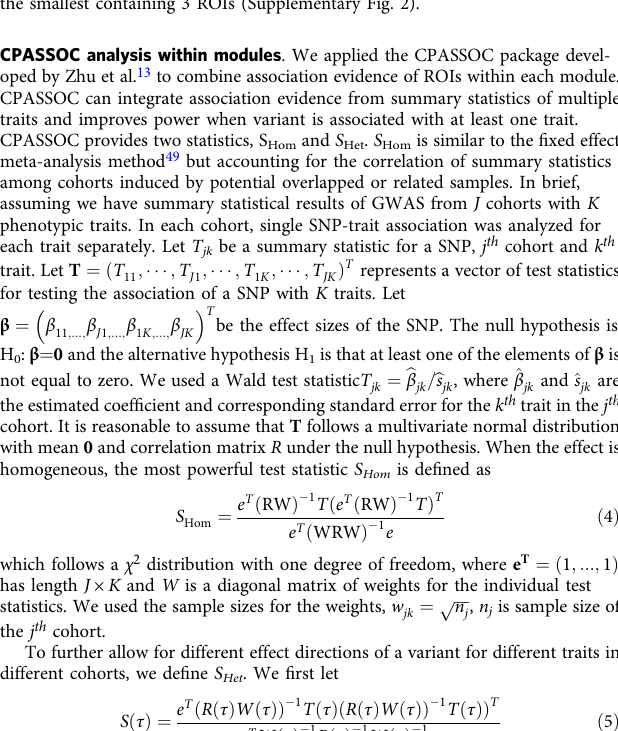
Supplementary Table 1. The Manhattan plots and Q-Q plots of CPASSOC analysis and single ROI GWAS for this module were showed in Fig. 1 and Supplementary Fig. 2. Genetic analysis of AV-45 PET imaging . 18 F-Florbetapir (AV-45) PET imaging was performed at baseline and 2-year follow-up for participants enrolled in the ADNI GO and two phases 22 . UC Berkeley extracted weighted AV-45 standardized uptake value ratio (SUVR) means for four main cortical regions: frontal, anterior, and posterior cingulate, lateral parietal and lateral temporal regions (version 2019.4.12) for ADNI-GO2 participants. They also calculated composite SUVR for cortical which is weighted SUVR mean in frontal, cingulate, parietal and temporal regions. These data can be downloaded from the ADNI database. We used the SUVR mean of composite region including whole cerebellum, pons/brainstem and eroded white matter as reference. Mean AV-45 SUVR of frontal, cingulate, lateral parietal, lateral temporal and composite cortical relative to the reference were calculated. The annual percent change in SUVR means at 2-year follow-up com- pared to baseline was used as the main quantitative phenotype for genetic analysis. The annual percent changes in AV-45 SUVR for all fi ve brain regions were approximately normally distributed (Supplementary Fig. 20). We collected 369 individuals with both SUVR measures for baseline and 2-year follow-up and whole-genome sequencing data. The samples included 120 healthy people, 26 people with AD, 64 people with late mild cognitive impairment (LMCI) and 159 people with early mild cognitive impairment (EMCI) diagnosed at baseline. The samples characteristics and demographics for samples are shown in Supplementary Table 11. WGS data from 817 ADNI participants were downloaded from the ADNI dataset. WGS was performed using blood-derived genomic DNA samples and sequenced on the Illumina HiSeq2000 using paired-end read chemistry and read lengths of 100bp at 30 – 40X coverage 50 . As previously described using Broad GATK and BWA-mem, reads were mapped and aligned to the human genome (build 37), then variants were called 50,51 . For single SNP association test, association test of SNP rs117028417 with phenotypes were performed using linear regression under an additive genetic model in PLINK. Baseline age and gender were included as covariates. For gene- based association test, we extracted 8 and 6 functional coding variants de fi ned as missense, in frame deletion/insertion, stop gained/lost, start gained/lost, splice acceptor/donor, or initiator/start codon for FAM222A and TRPV4 respectively. All of those variants are rare with minor allele frequency (MAF)< 0.01 in ADNI samples. Gene-based association tests were performed using burden and SKAT 52 , adjusting age and sex as covariates.